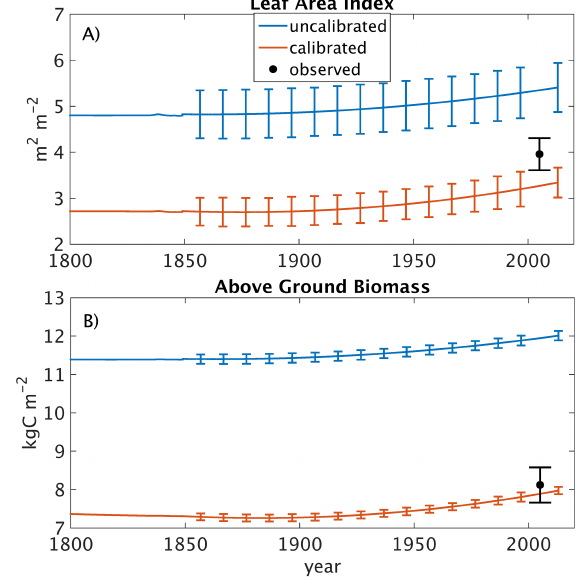
Figure 4. Simulation of (a) leaf area index and (b) aboveground biomass for both uncalibrated and calibrated ( V cmax downscaled, limited nitrogen) simulation. Observations are from Bradford et al. (2008) with uncertainty bars representing standard error. Uncer- tainty bars on simulated runs represent 95% confidence of biomass variation as a result of cycling the site-level meteorology observa-